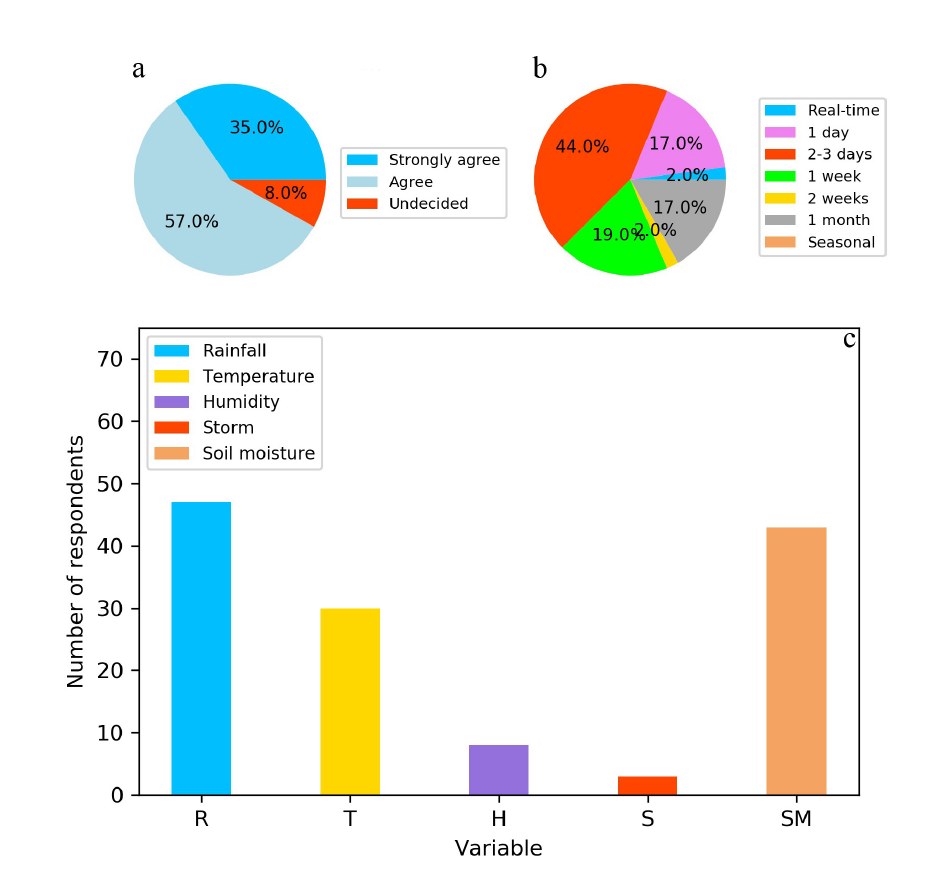
Figure 6. ( a ) Farmer’s perception on the importance of forecast information, ( b ) the percentage of forecast lead-time needs by smallholder farmers, and ( c ) forecast variable needs of smallholder farm- ers. R stands for Rainfall, T stands for Temperature, H stands for humidity, S stands for storm, and SM stands for soil